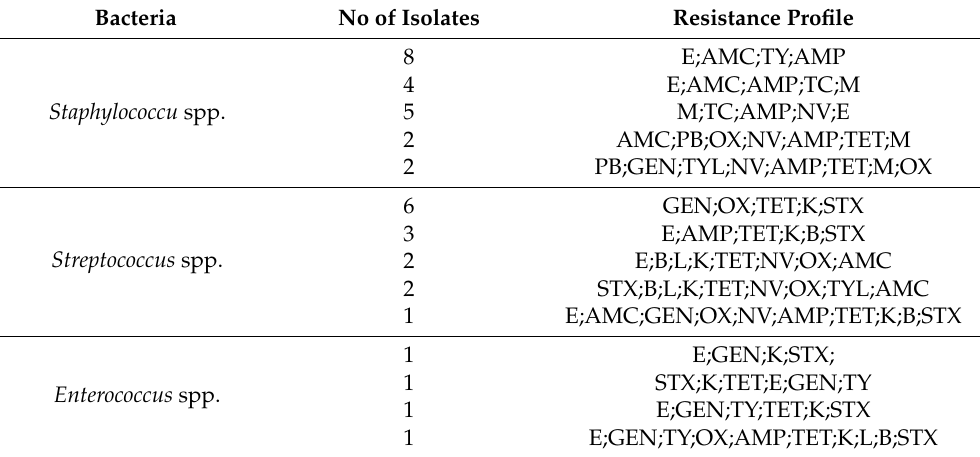
Table 5. Patterns of resistance identified in Staphylococcus spp. ( n = 21), Streptococcus spp. ( n = 14) and Enterococcus spp. ( n = 4)